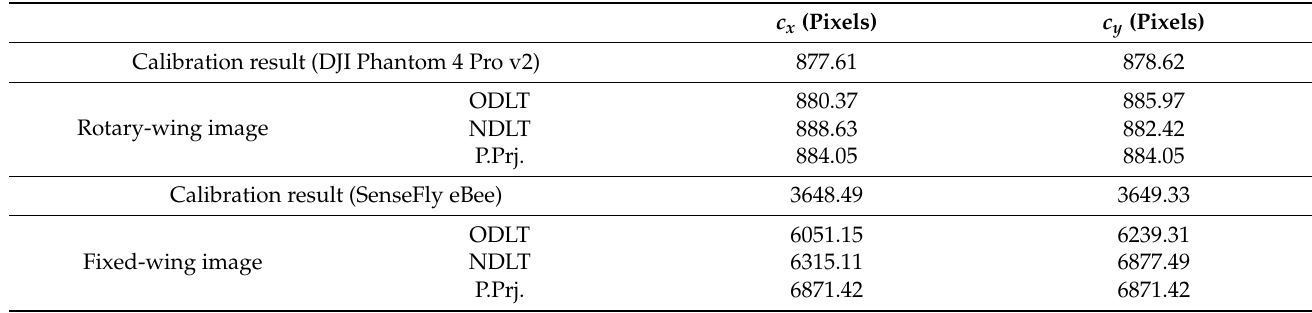
Table 7. Estimated EOP and reprojection errors of UAVs.